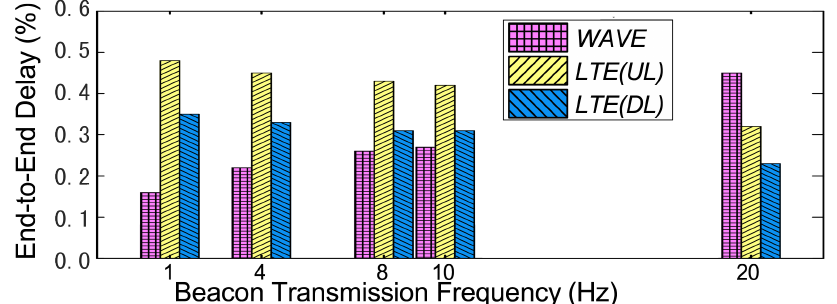
Figure 8. Beacon Transmission Frequency vs. delay (a).